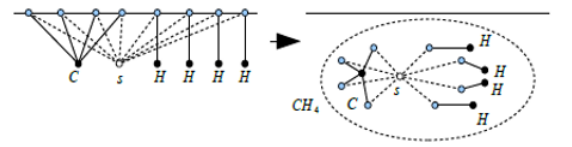
Fig. 2. Convolutions for